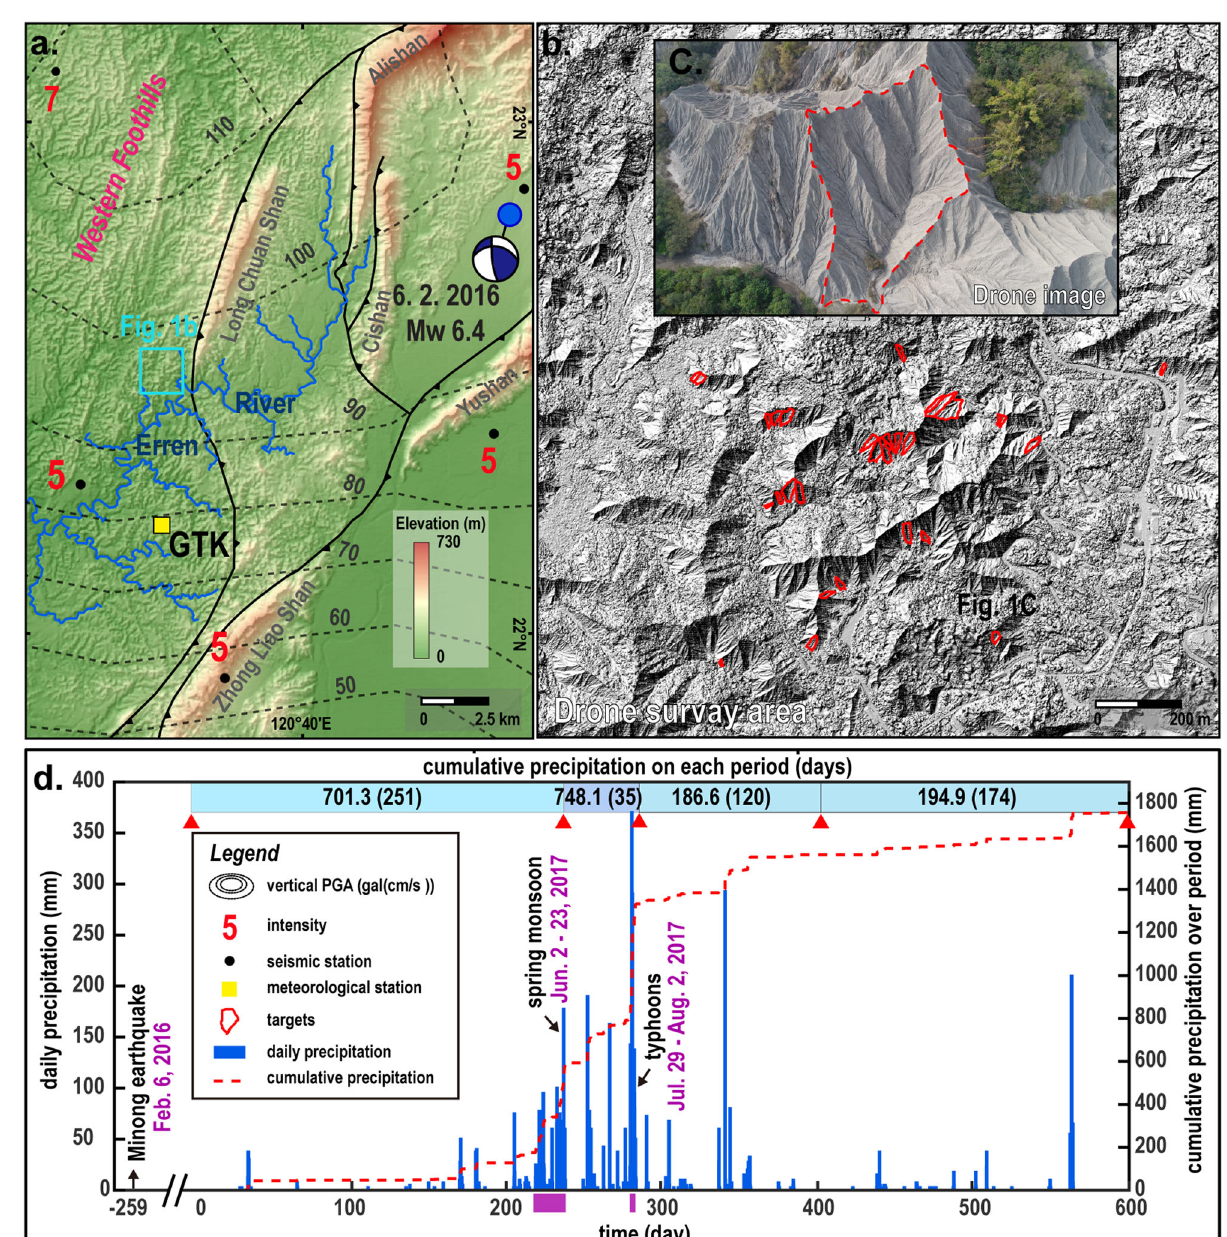
Fig. 1 Location and geological background in front of Taiwan orogenic belt. a Color-shaded relief map driven from 20 m spatial resolution digital elevation model data (downloaded from https://data.gov.tw/dataset/35430) showing the distribution of major active faults (downloaded from https://www. moeacgs.gov.tw) and intensity of 2016 Meinong earthquakes (red number). Intensity and focal mechanism solution was acquired from the Central Weather Bureau (https://www.cwb.gov.tw/eng/) with a focal mechanism of 295°, 30°, and 37° in a strike, dip, and rake. The black dashed lines denote vertical PGA contours (https://scweb.cwb.gov.tw/special/20160206pga.asp). GTK (yellow square) is a meteorological station providing hourly precipitation data. b Shaded relief map of the drone survey area with 30 cm spatial resolution digital surface model data is conducted by this study. The boundaries of target (red block) mapping by this study. c Drone image of a typical badland catchment (red dashed block) is conducted by this study. d Daily and cumulative precipitation from hourly measurements, red triangles mean UAV survey